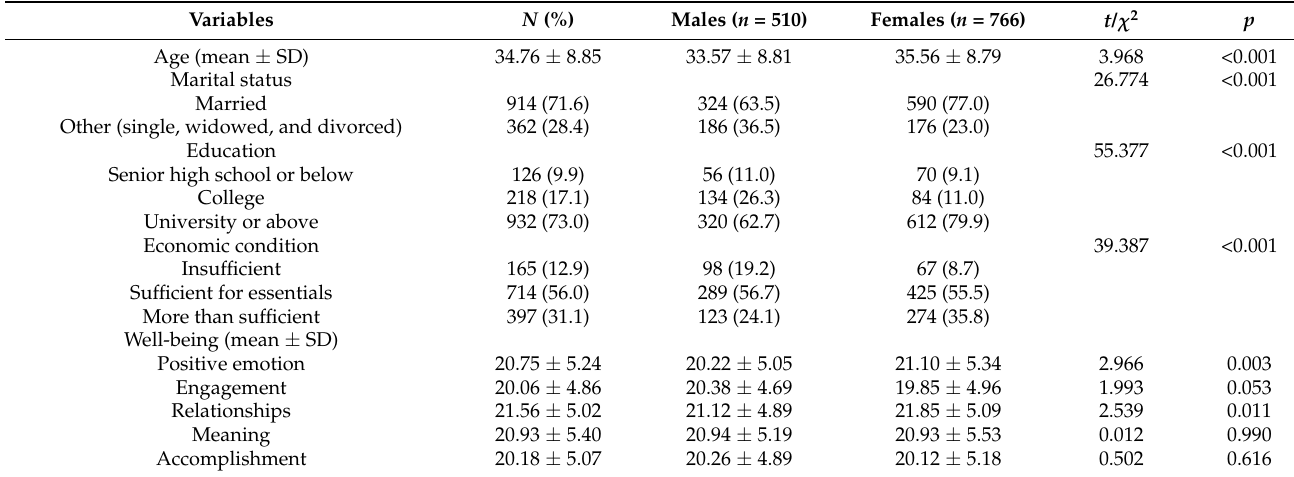
Table 2. Descriptive statistics and t -test/chi-squared test results ( n = 1276).